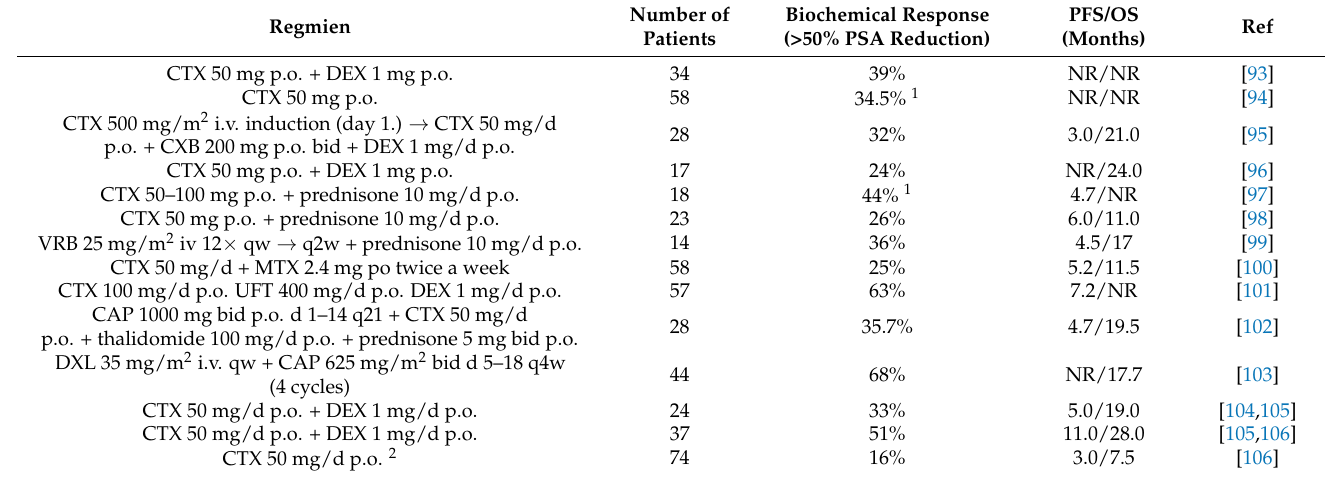
Table 1. Studies evaluating metronomic chemotherapy in prostate